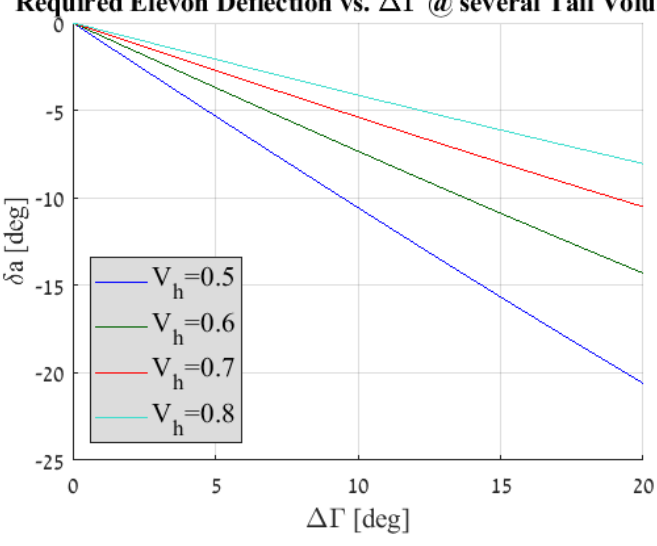
Figure 14. Elevon deflection angle vs. ∆Γ for several horizontal tail